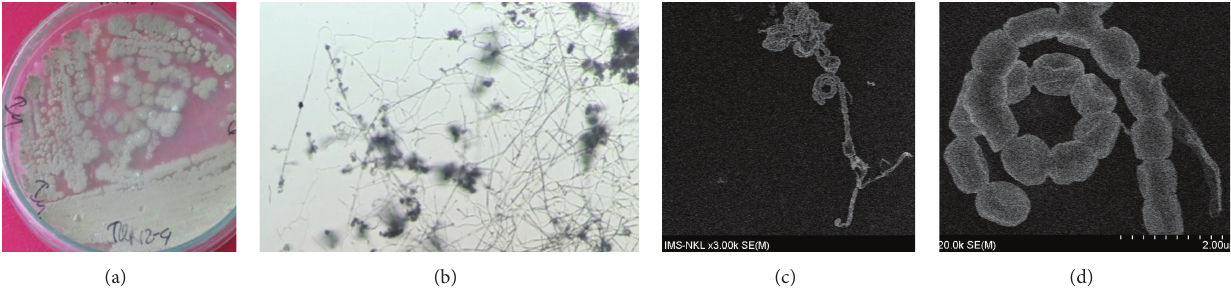
Figure 2: Morphology of isolate TQR12-4 grown on ISP medium #4 (7-day culture): colonies (a); light microscope image ( × 40); mycelia and spore chains (b); scanning electron micrograph: spore chain (c); and spores (d). Bar = 2 𝜇